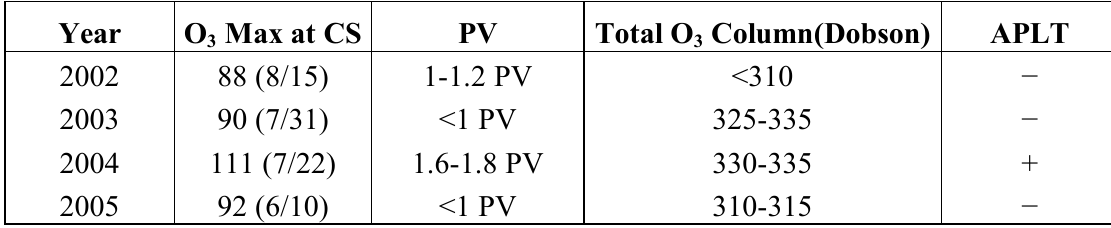
Table 3. The four highest O episodes at CS: 2004 was the highest event with the only one 3 year with O > 100 ppbv; 2005 was the second highest event; 2003 was third and 2002 was 3 fourth. Values of PV and total O column were obtained from Figure 18 (top and middle 3 panels) in the area over